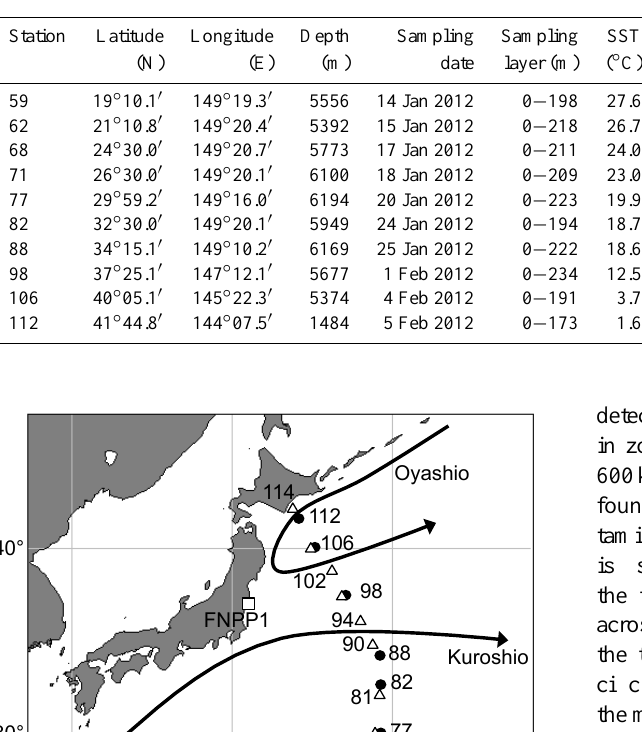
Table 1. Radiocesium activities in zooplankton in western North Pacific Ocean 10 months after the FNPP1 accident. The radiocesium activities and biomasses are based on the dry weight. The radiocesium activities were decay corrected to the date of sampling. The uncertainty of radiocesium activity is the sum of errors due to the gamma counting, calibration, and cascade correction and is given at one sigma. SST means sea surface temperature.